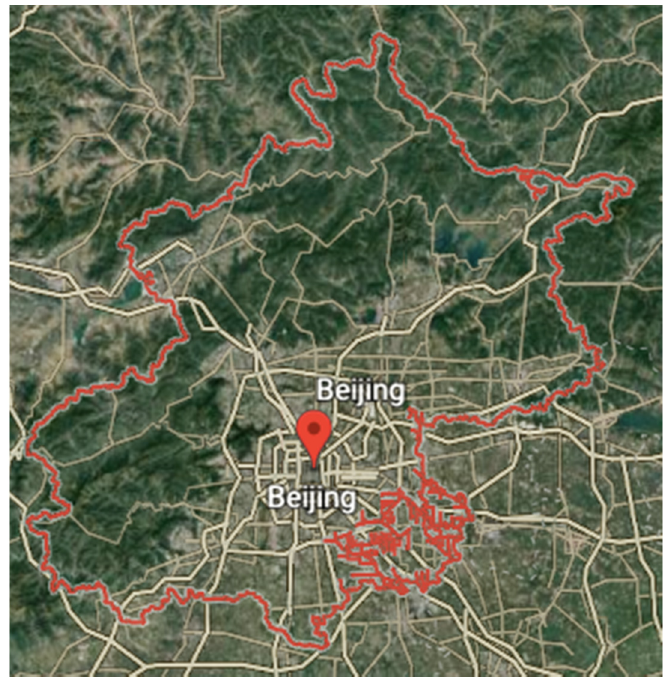
Figure 1. The map of Beijing (source: Google).